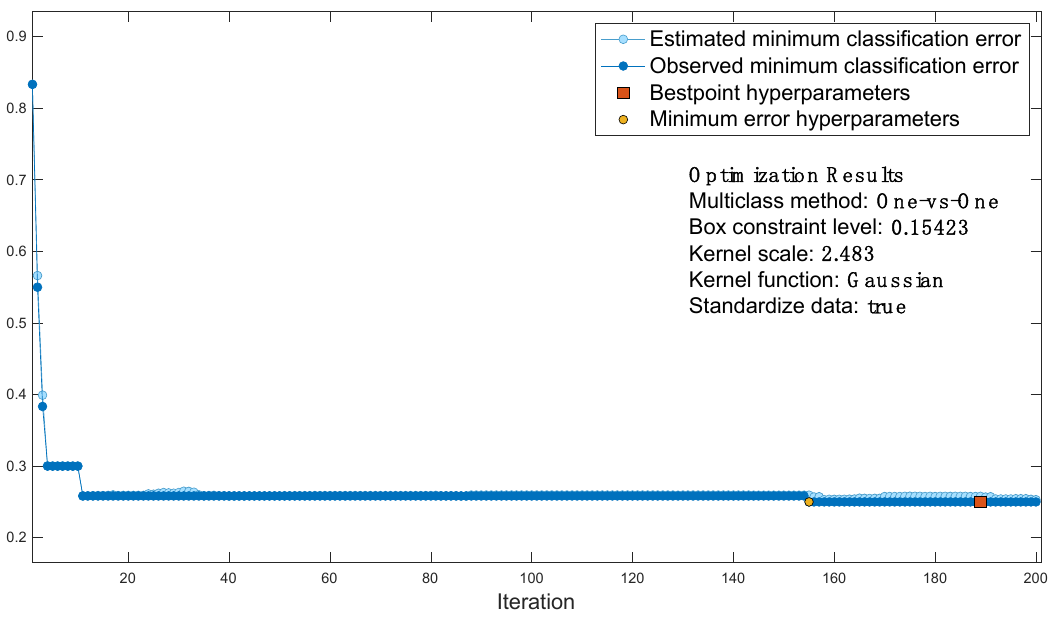
Figure 10. AI classification error function trained with the penalty matrix.